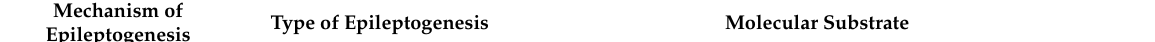
Table 2. Molecular mechanisms underlying immune-mediated